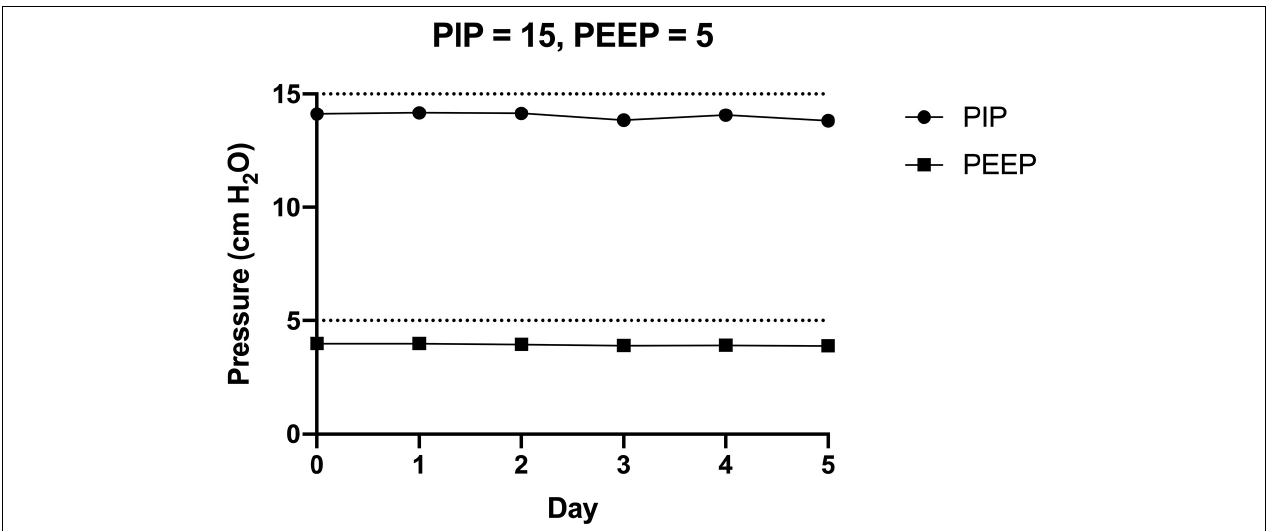
FIGURE 7 | The FALCON prototype ventilator was connected to the experimental setup and run (peak inspiratory pressure = 10 cm H 2 O, positive end expiratory pressure = 5 cm H 2 O, respiratory rate = 10 breaths per min, and normal lung compliance of 74 mL/cm H 2 O) continuously for 5 days. Pressures were recorded for 10 consecutive respiratory cycles each day, and the mean peak inspiratory pressure (PIP) and positive end expiratory pressure (PEEP) for each day are